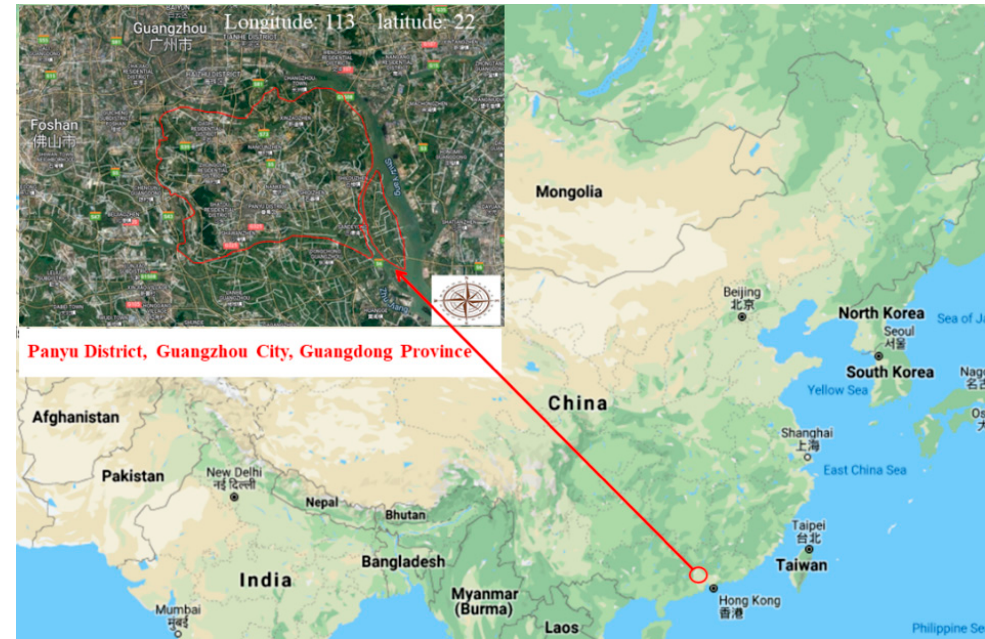
Figure 1. Geographical location of the study area.